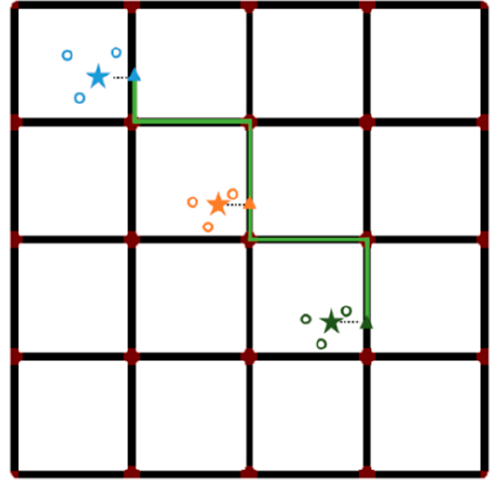
Figure 7. Reconstruct trajectory by connecting all matched anchor points.